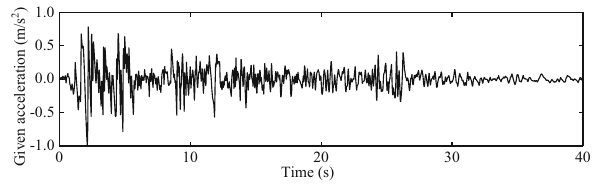
Fig. 8 Time history of the given acceleration